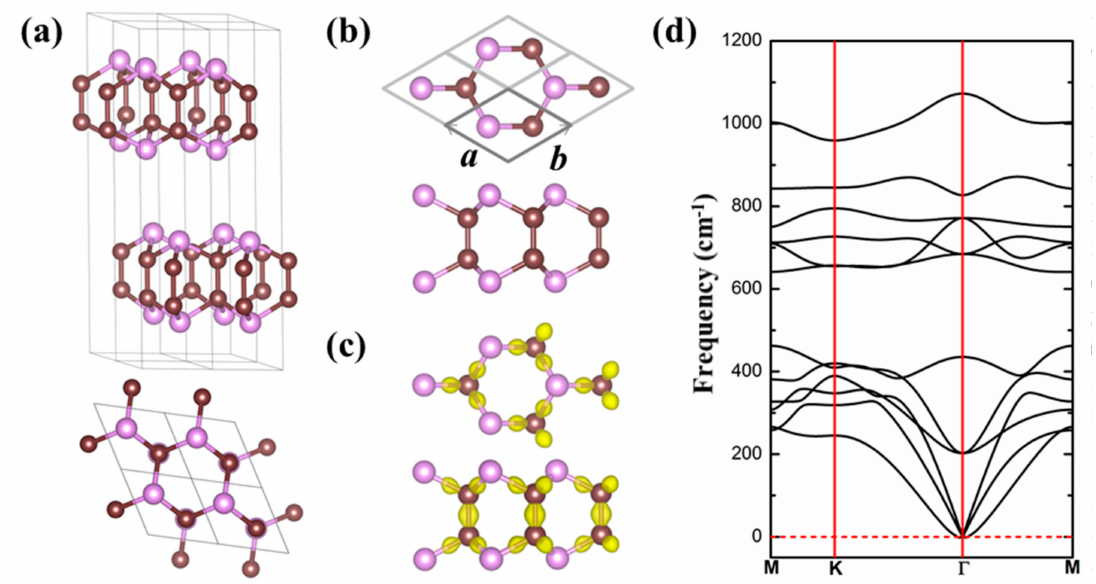
Figure 1. ( a , b ) Are the top and side views of the crystal structures of GaSe-like bulk and 2D monolayer phosphorus carbide (PC), respectively. Panel ( c ) is the charge density difference of GaSe-like monolayer PC. Panel ( d ) is phonon spectrum of 2D PC monolayer. The purple and brown balls represent P and C atoms, respectively. In panel ( c ), the isosurface value is 0.03 e / a 3 0